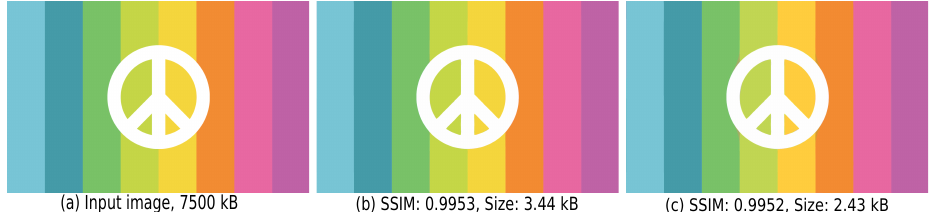
Figure 5. Benefits of compressing the three Y, Cb, and Cr channels separately. ( a ) Input image. ( b ) Using the same compression parameters for all three channels, i.e., n 1 = n 2 = n 3 = n 4 = 1. ( c ) Using different parameters for the three channels, i.e., n 1 = 0.5, n 2 = 5, n 3 = 2, n 4 = 1 (see Figure 4).